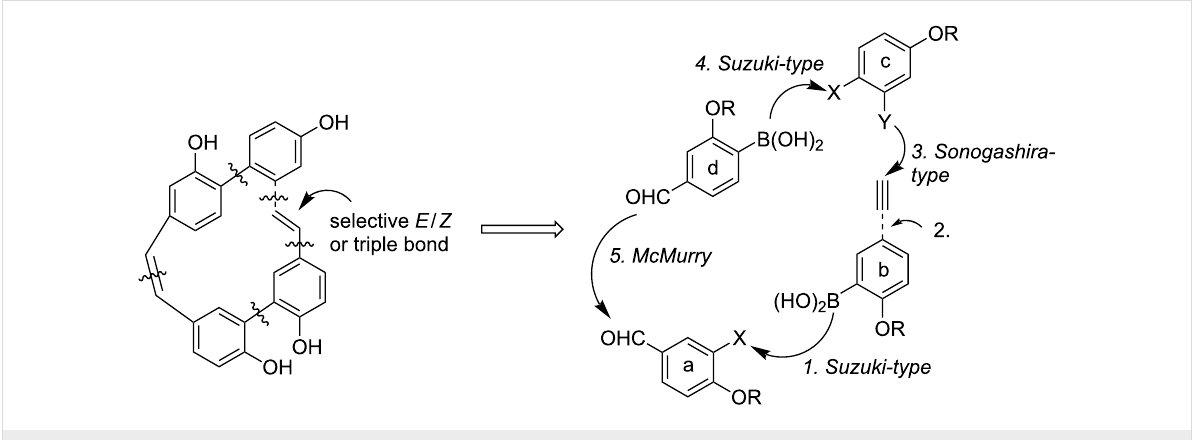
Scheme 2: Strategy of synthesis for the macrocycles 5 – 7 .